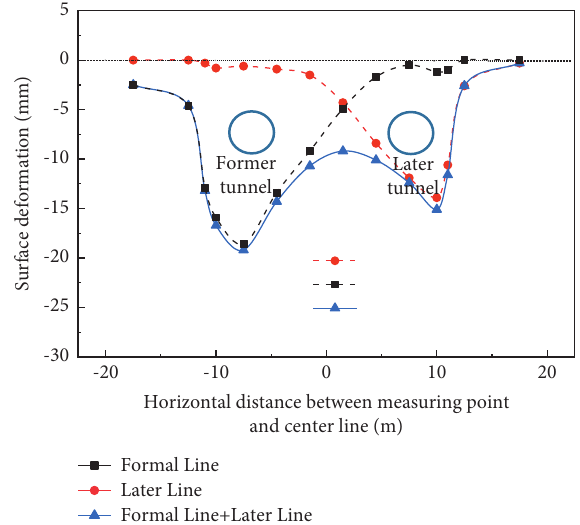
Figure 6: Measured curve of surface deformation of a section of Hangzhou Metro Line